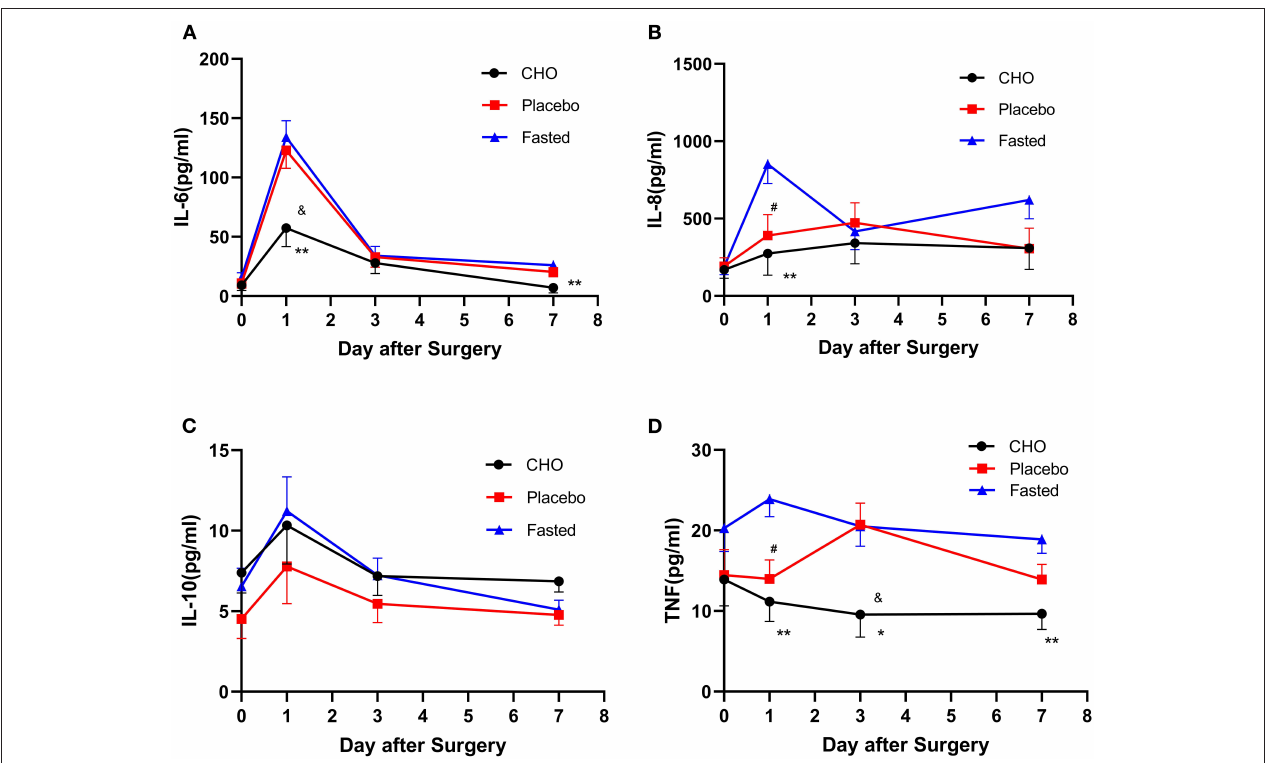
FIGURE 3 | Changes in the levels of postoperative inflammatory markers including IL-6 (A) , IL-8 (B) , IL-10 (C) , and TNF (D) in different groups. CHO vs. 0.01; Placebo vs. Fasted, # P ≤ 0.05, Placebo vs. Fasted, & P ≤ 0.05, * P ≤ 0.05, ** P ≤